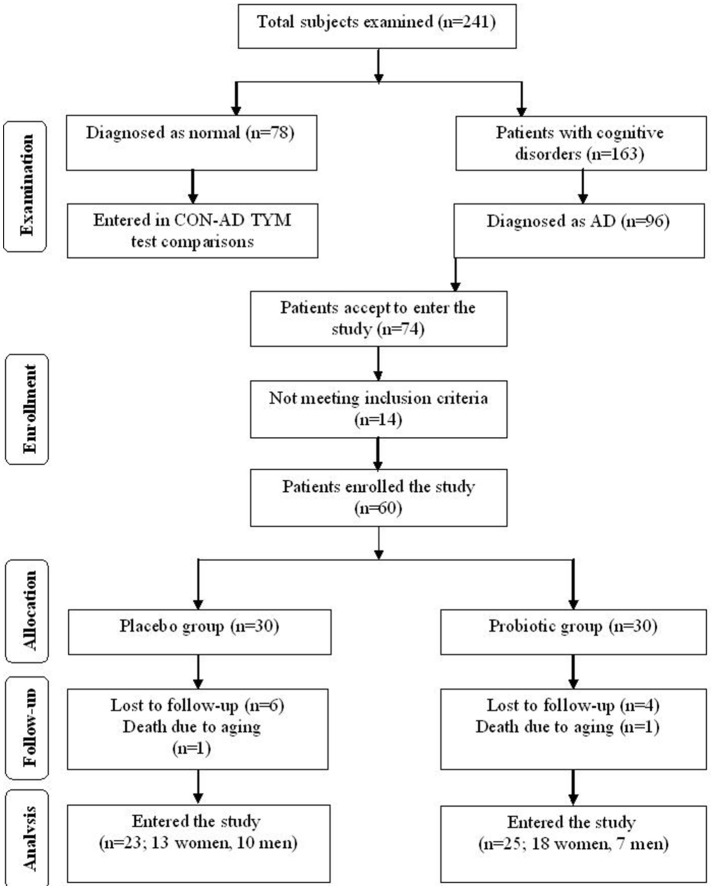
Summary of patient flow.